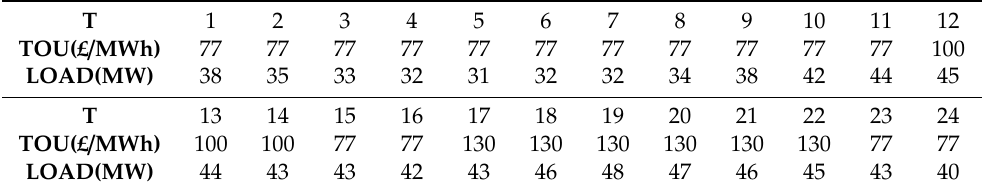
Table 1. TOU (time-of-use) price and load data in a day.